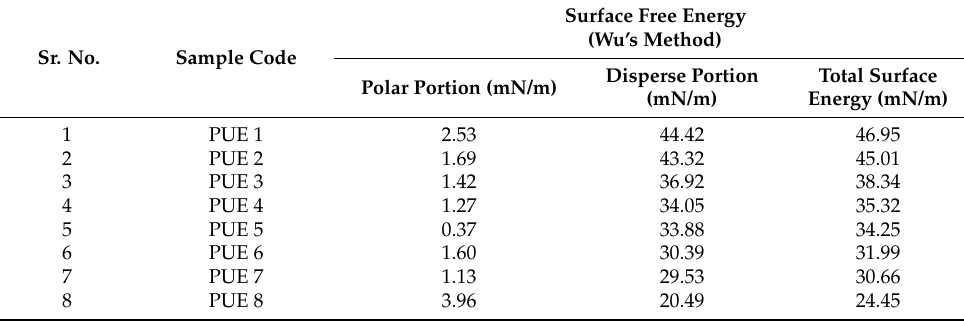
Table 4. Data of the total surface energy calculated using Wu’s method.